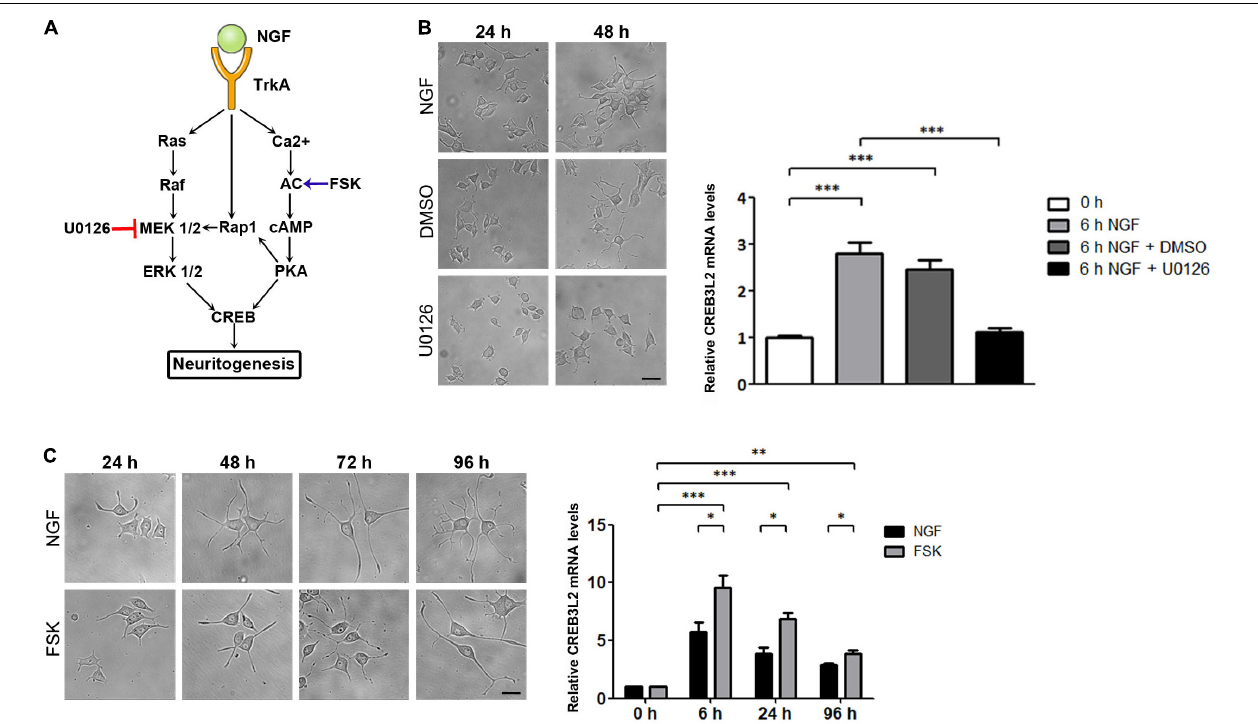
FIGURE 3 | Effect of U0126 and Forskolin on neuritogenesis and CREB3L2 expression. PC12 cells differentiated with NGF during the indicated times in the presence of vehicle (DMSO), U0126 (10 µ M), or Forskolin (FSK, 15 µ M). DMSO and U0126 were added 2 h before NGF induction. (A) Schematic representation of NGF-activated signaling pathways in PC12 cells with the site of action of U0126 and FSK. (B) Left panel: Representative images of cells incubated with NGF, or with NGF and either DMSO or the MAPK/ERK 1/2 inhibitor, U0126, during the indicated times. Scale bar: 10 µ m. Right panel: qRT-PCR of CREB3L2 transcript levels performed with total RNA extracted from cells incubated with NGF at the indicated times. (C) Left panel: Representative images of cells incubated with NGF or Forskolin during the indicated times. Scale bar: 10 µ m. Right panel: qRT-PCR of CREB3L2 transcript levels performed with total RNA extracted from cells incubated with Forskolin; mRNA values (B,C) were normalized to the levels of TBP and expressed according to the 2 − (cid:49)(cid:49) Ct method relative to the expression level of CREB3L2 in untreated cells (0 h, set as 1). Bars represent the mean ± SEM of three independent experiments carried out in triplicates. Statistical data analysis was performed using ANOVA test followed by Bonferroni multiple comparison post-test, considering statistically significant a value of p < 0.05 ( ∗∗ p < 0.001, ∗∗∗ p <